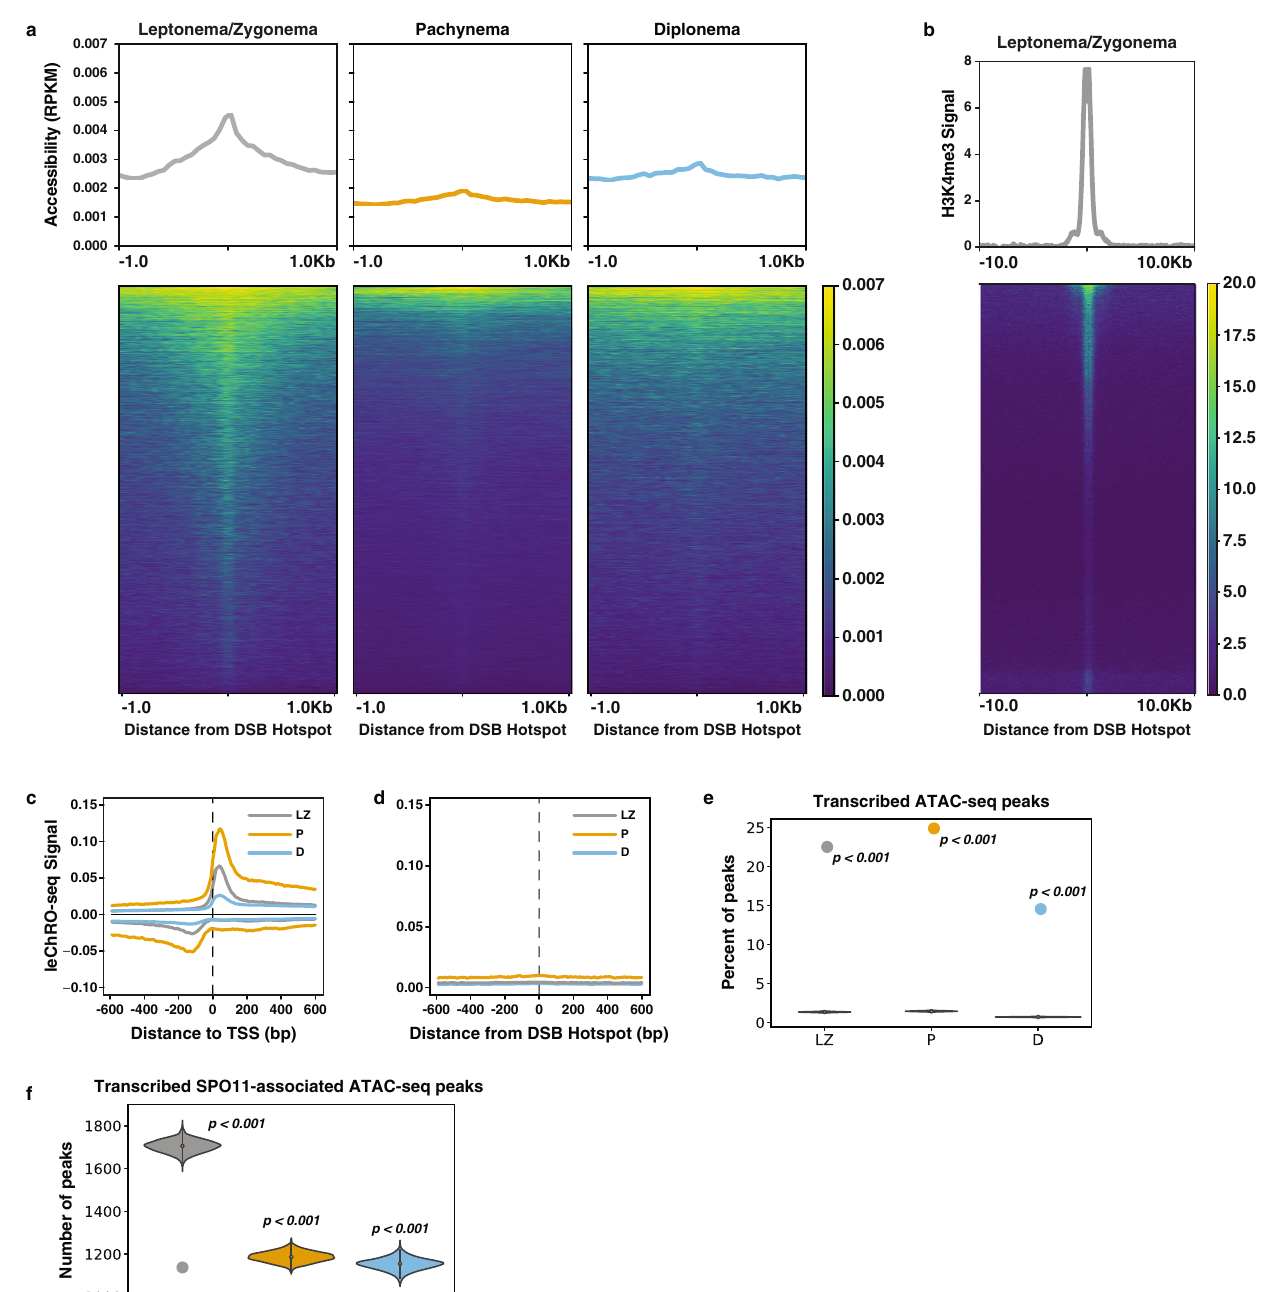
Fig. 7 | Nascent transcription and chromatin accessibility at DSB and meiotic recombination hotspots. a Metaplots (top) and heatmaps (bottom) of RPKM- normalized ATAC-seq signal centered on DSB hotspots inferred from SPO11 oligos forleptonema/zygonema(LZ),pachynema(P),anddiplonema(D).Peaksaresorted in all prophase I substages by decreasing order of ATAC-seq signal intensity in leptonema/zygonema. b Metaplot (top) and heatmap(bottom) of H3K4me3signal centered on DSB hotspots for LZ. c , d Metaplots of the average leChRO-seq signal centeredonannotatedTSSs(C)andSPO11oligos(D)forLZ,P,and D. e Percentage